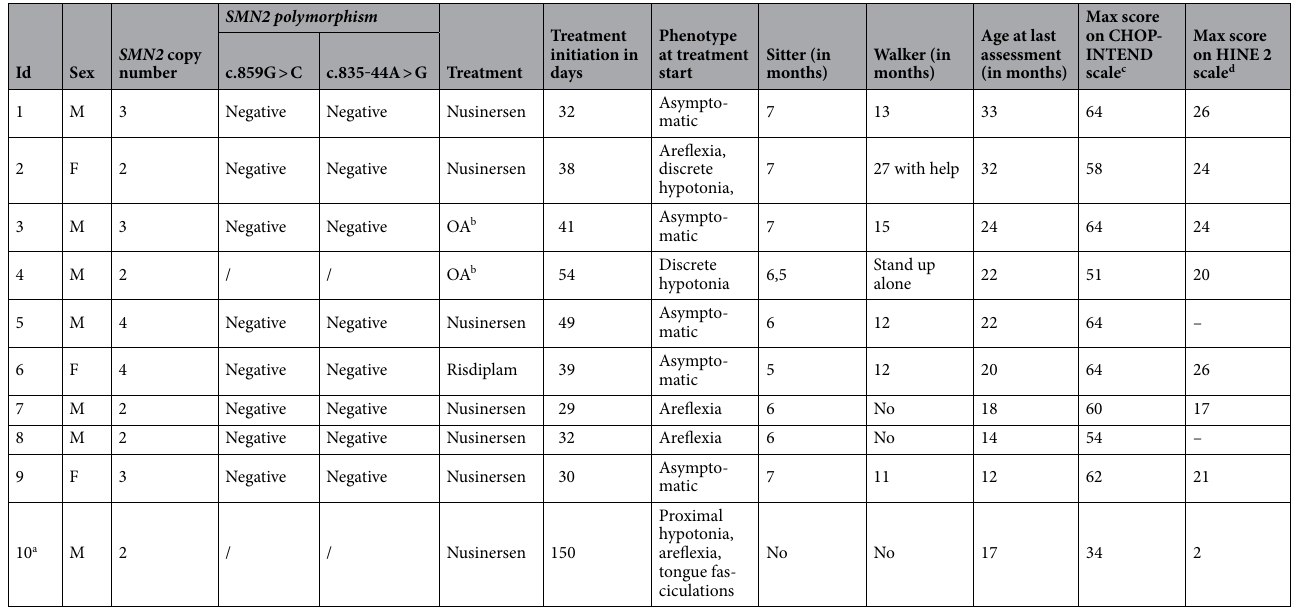
Table 2. SMN2 copy number and polymorphisms, treatment, and evolution of symptoms of SMA patients identified during the study period. a Compound heterozygous patient identified at the age of 4 months. b Onasemnogene abeparvovec-xioi. c CHOP-INTEND maximum score is 64. d HINE Sect. “Results” maximum score is 26. A dash indicates that the test was not